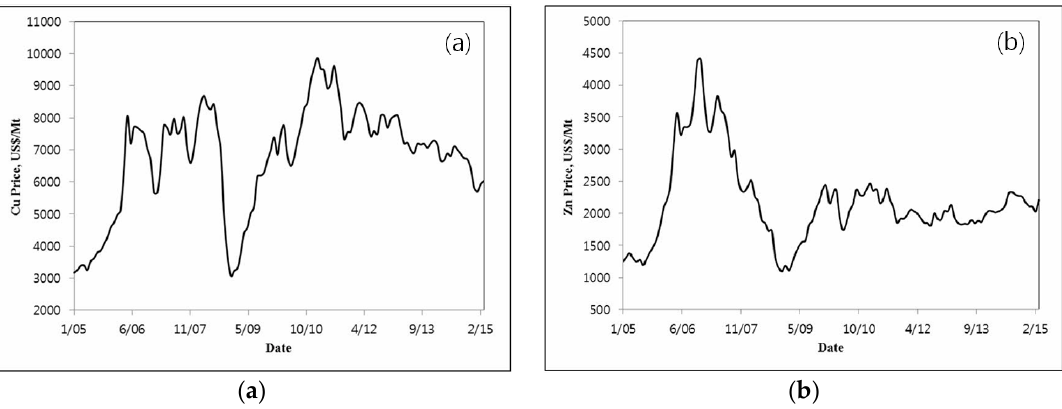
Figure 4. Price fluctuation graph. ( a ) Average monthly copper prices; ( b ) Average monthly zinc prices. To plot a cumulative relative frequency curve, the number of classes for copper prices was set at 13, and class width was set at 600 $/tonne based on Equation (1). In the same manner, the number of classes for zinc prices was set at 12, and class width was set at 300 $/tonne. The results of calculating